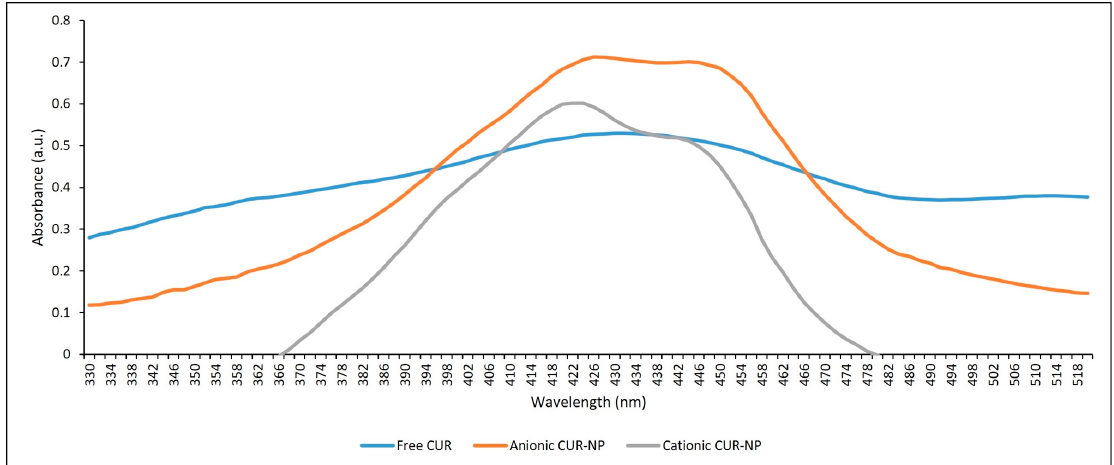
Figure 2. Absorption spectrum of free CUR, anionic and cationic CUR-NP.